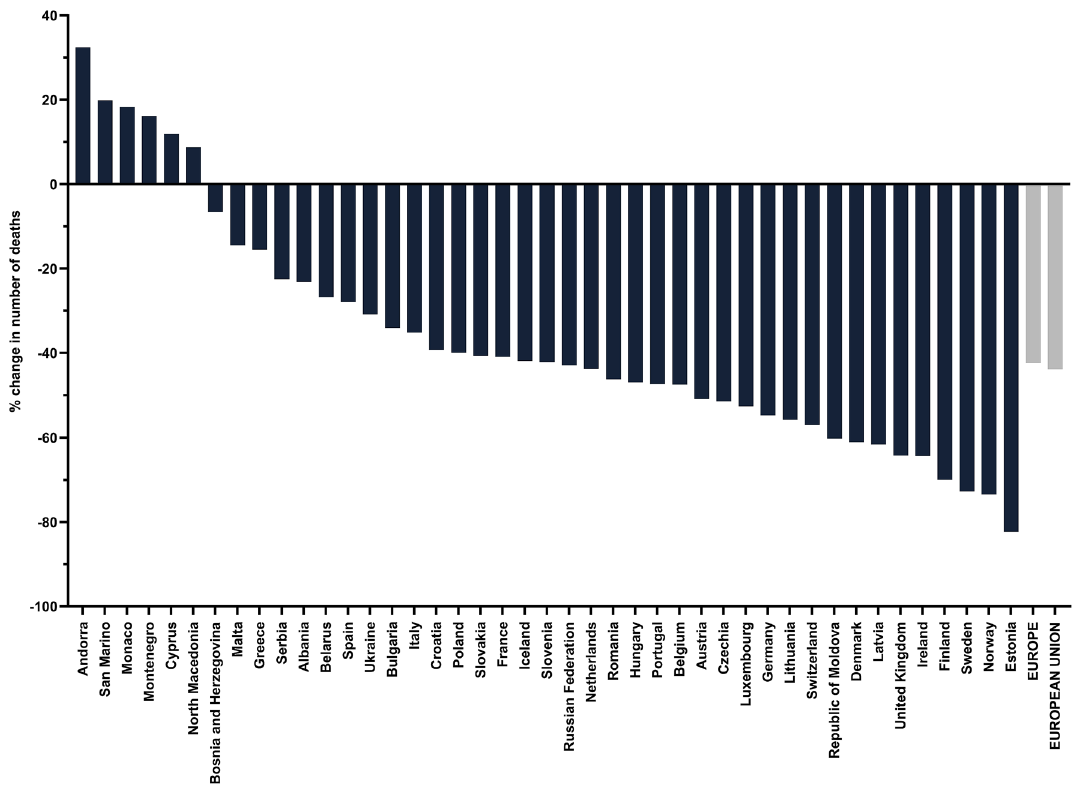
Figure 2. Percent change in number of deaths attributable to air pollution in 2019 compared to